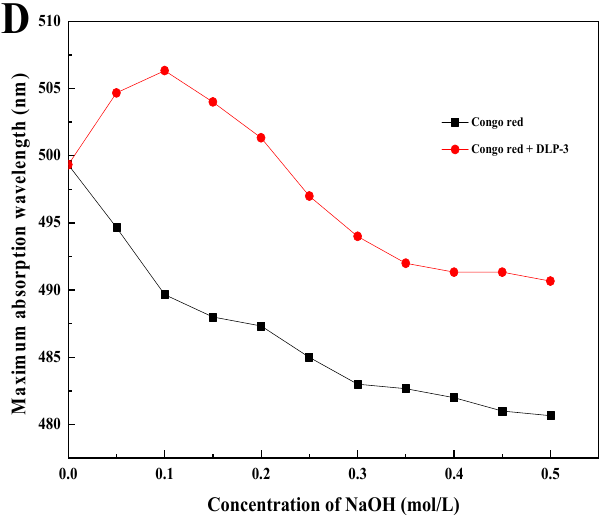
Figure 3. ( A , B ) SEM (5000× and 10,000×) of DLP-3; ( C ) FT-IR spectra of DLP-3 in the range of 4000–400 cm − 1 ; ( D ) changes in absorption wavelength maximum of a mixture of Congo red and DLP-3 at various concentrations of NaOH.